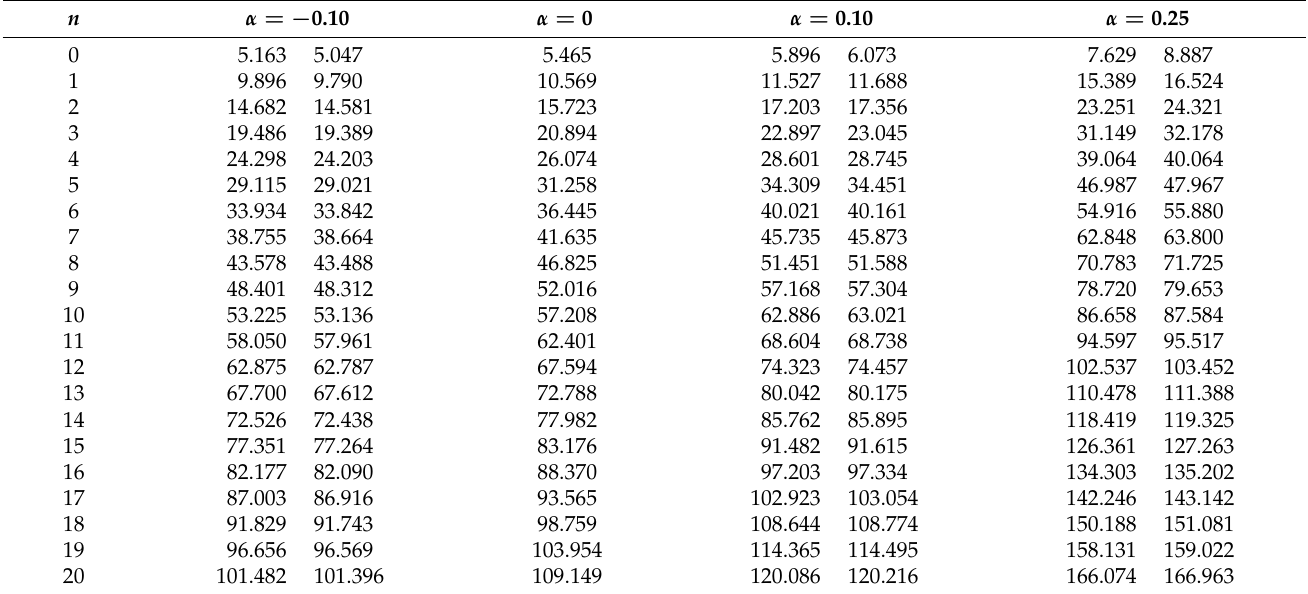
Table 1. The critical chemical potential µ c of the vector operator O x for the masses of the vector field = 3/4 (right column) with different values of the Gauss–Bonnet m 2 L 2 = 3/4 (left column) and m 2 L 2 eff parameter from the ground state to the 20-th excited state. It should be noted that the critical chemical potentials for the different choices of the vector mass are the same for the case of α = 0, i.e., the Schwarzschild-AdS black